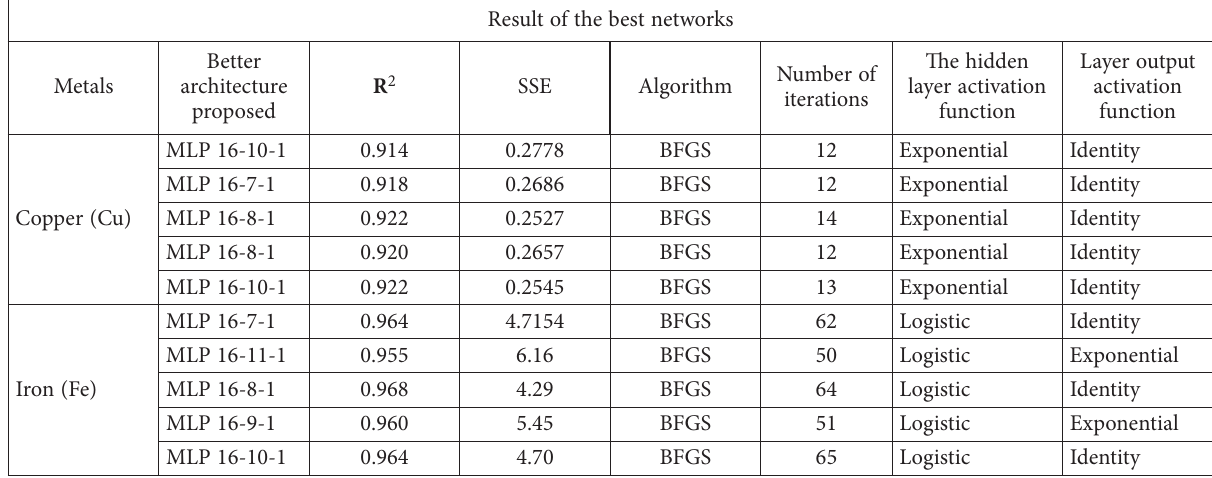
Table 5. Determination coefficient R 2 and SSE obtained by STATISTICA12 on the three sets